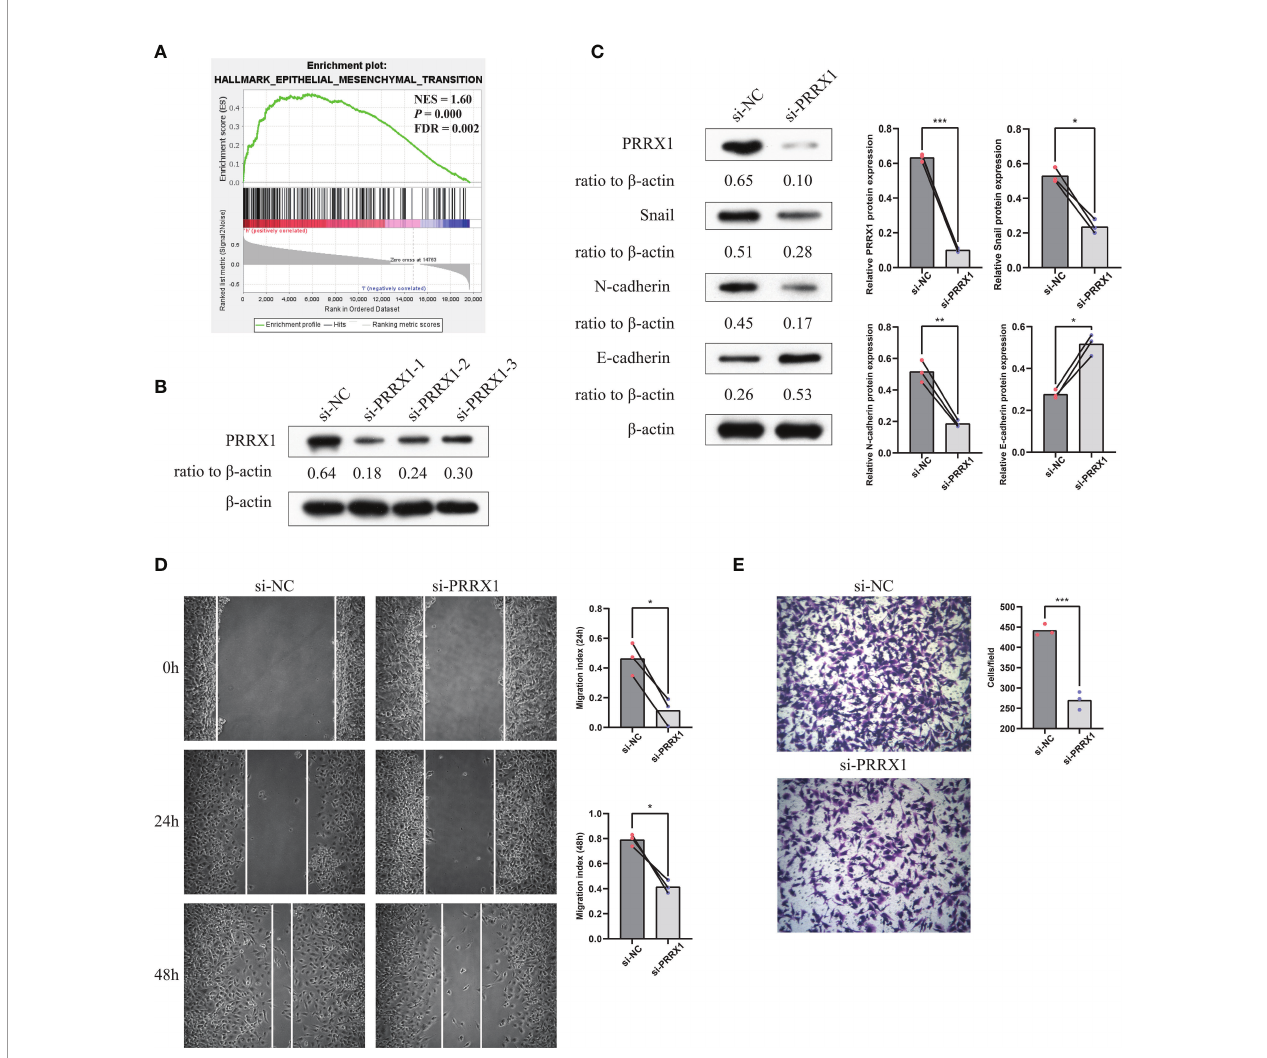
FIGURE 9 | Knockdown of PRRX1 in UM cell suppresses EMT, migration and invasion in vitro . (A) GSEA results revealed that PRRX1 expression signi fi cantly positively correlated with the EMT signatures (NES = 1.6, p < 0.001, FDR = 0.002). (B) WB showed PRRX1 protein level with three different PRRX1 – siRNA treatment, relative expression levels of proteins were normalized based on the b -actin levels. (C) The in fl uence of PRRX1 knockdown on the expression level of EMT-related factors (Snail, N-cadherin and E-cadherin) were analyzed using WB, relative expression levels of proteins were normalized based on the b -actin levels (left: representative images of three independent experiments; right: quantitative analyses, n = 3, * p < 0.05; ** p < 0.01; *** p < 0.001, paired Student ’ s t-test). (D) Wound-healing assay was used to detect cell migration ability in si-NC and si- PRRX1 UM cells (left: representative images of three independent experiments; right: quantitative analyses, n = 3, * p < 0.05, paired Student ’ s t-test). (E) Transwell assays showed the effect of PRRX1 knockdown on UM cell invasion (left: representative images of three independent experiments; right: quantitative analyses, n = 3, *** p < 0.001, unpaired Student ’ s